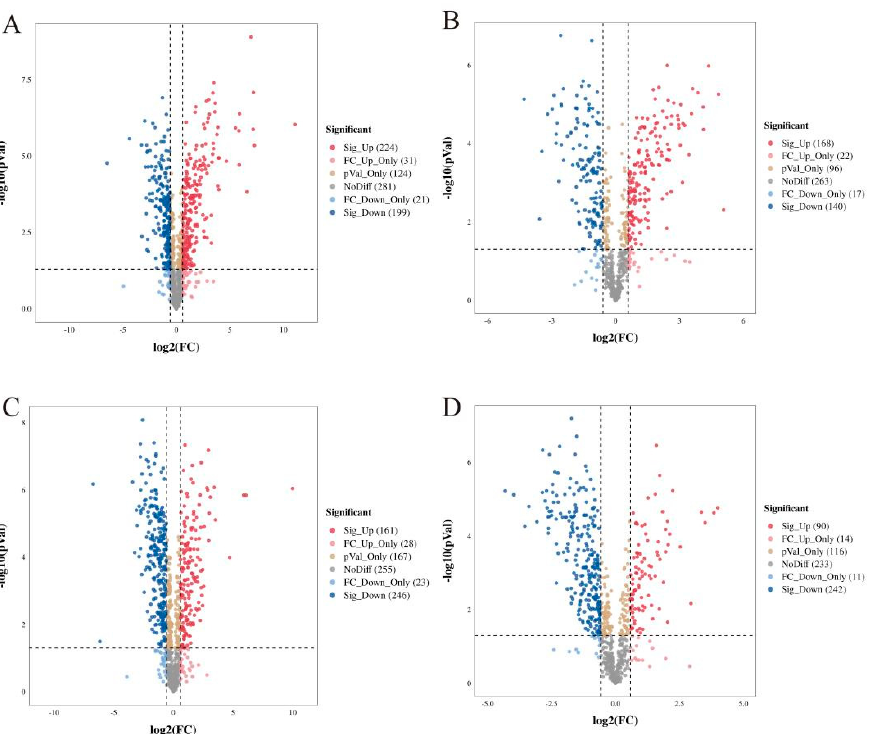
Figure 4. Volcano diagram of differential metabolites from different sources of YCH. ( A , B ) The differential metabolites of Wild and Cultivated I detected in the positive and negative ion modes, respectively. ( C , D ) The differential metabolites of Wild and Cultivated II detected in the positive and negative ion modes, respectively. The plots are of log probability vs. fold change, with color coding for different categories of significant